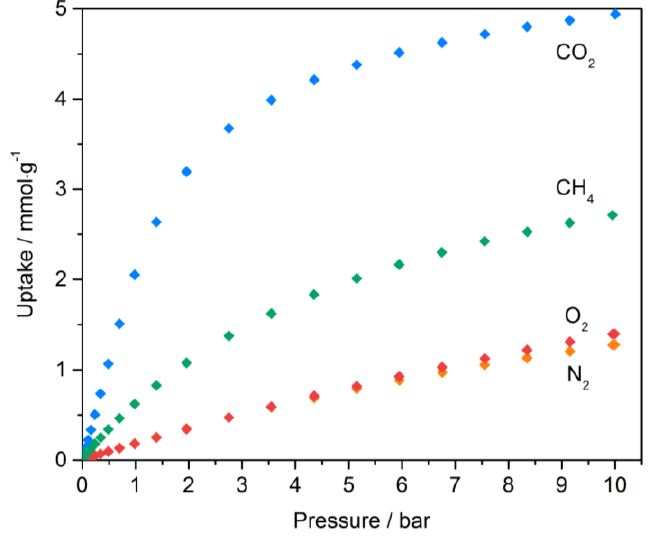
Figure 2. Adsorption isotherms for CO 2 , CH 4 , O 2 and N 2 at 298 K.